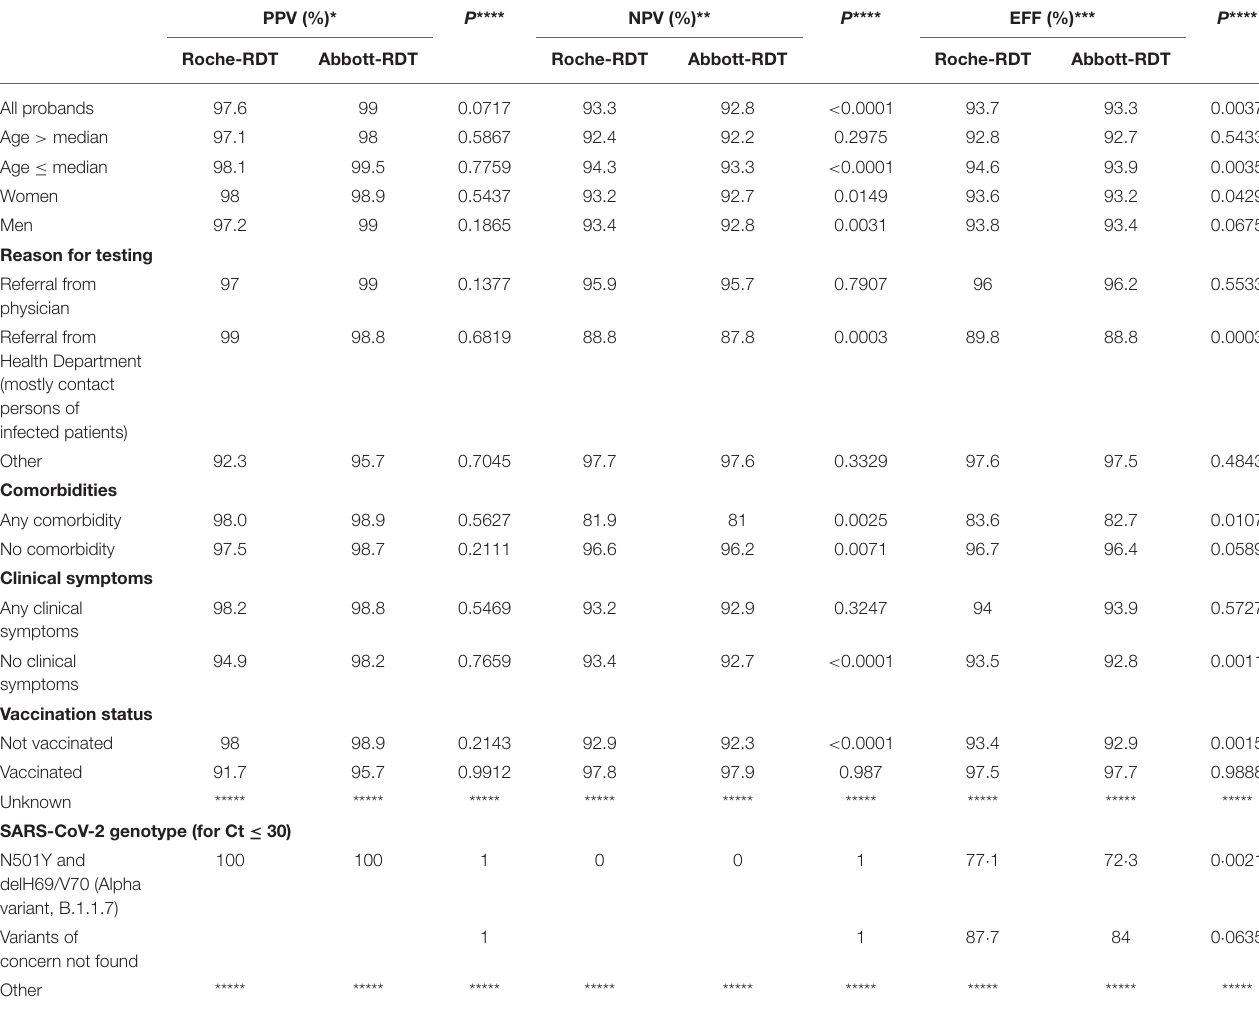
TABLE 2B | Diagnostic performance of two commercial RDTs for SARS CoV-2 antigen (part